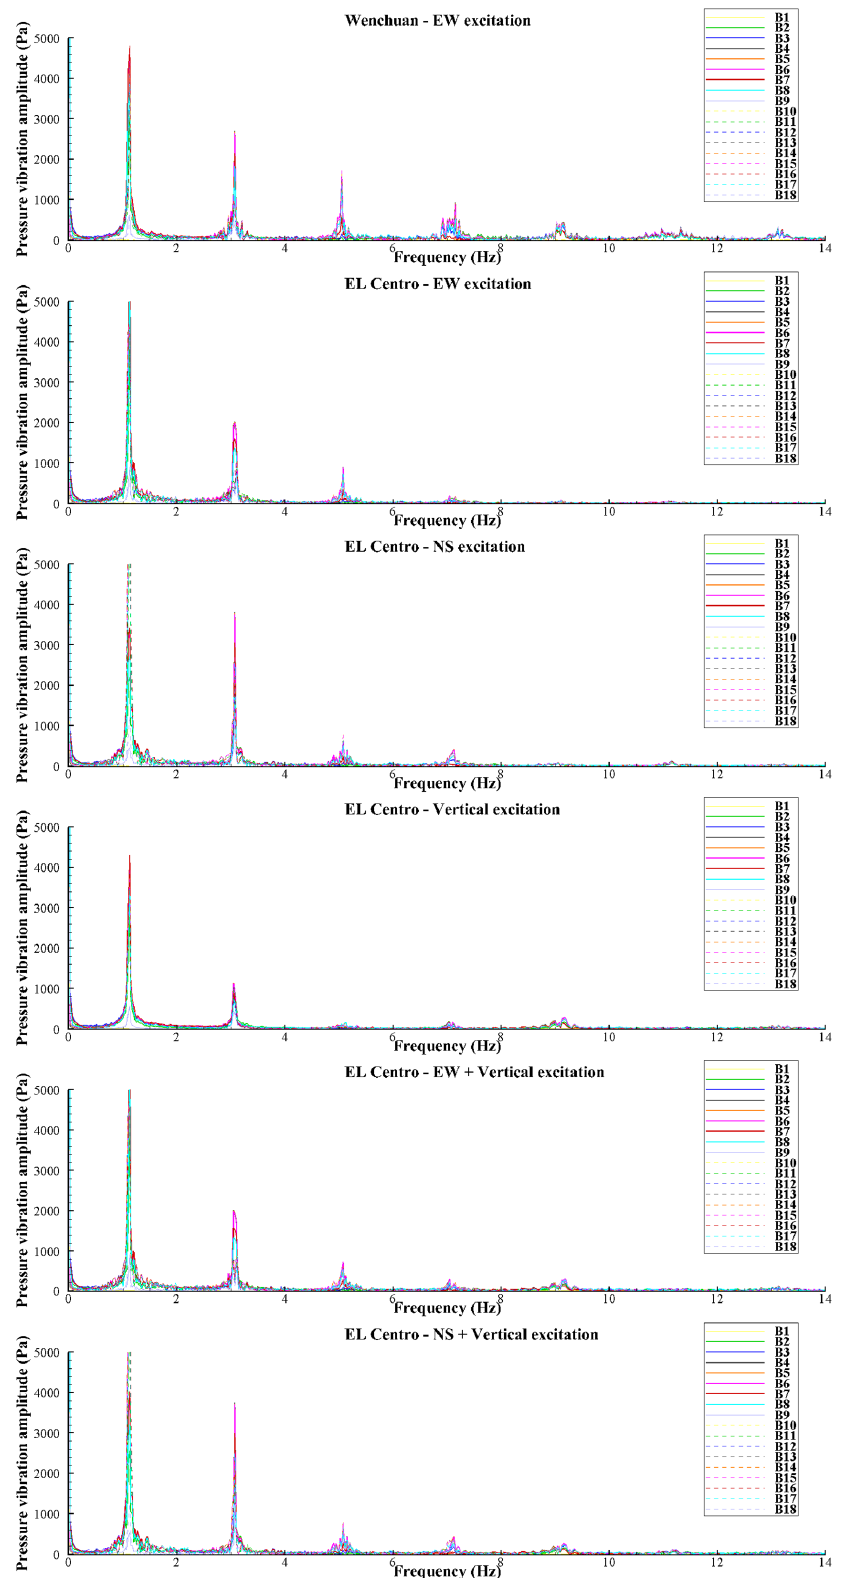
Figure 15. The fast Fourier transform of pressure time − series at the monitoring boundary points for different seismic excitations at the designed water